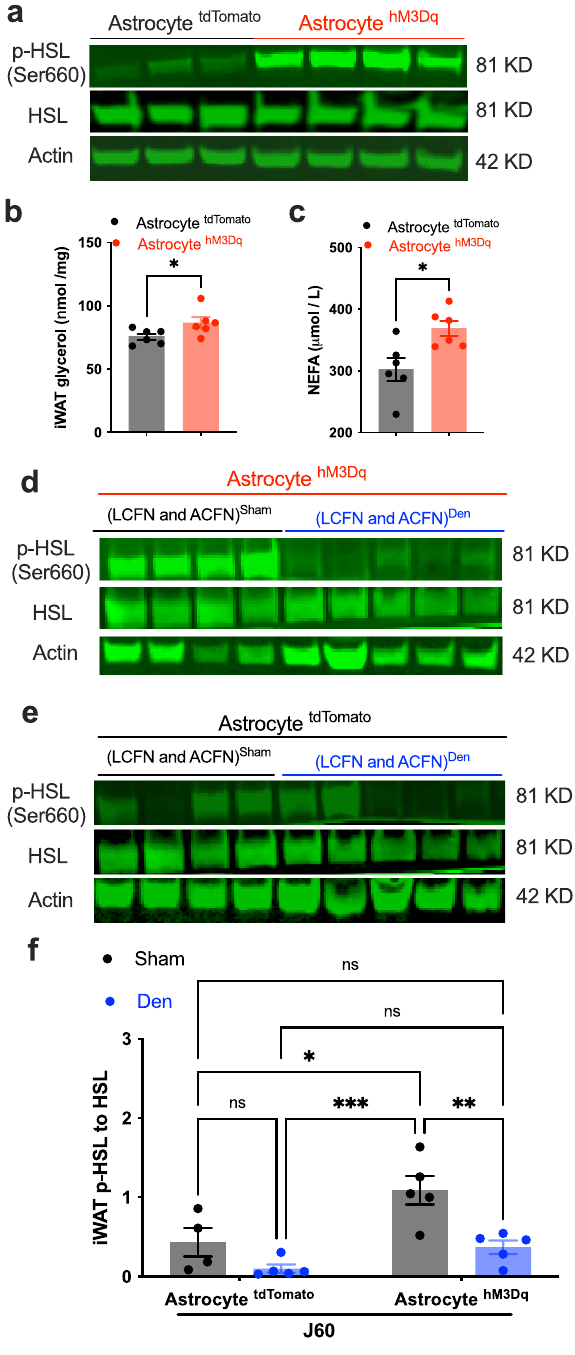
Fig. 6 | Local neural inputs are required for astrocyte regulation of lipolysis. a – c Chemogenetic stimulation of astrocytes in the ARH with J60 via i.p. induced iWAT lipolysis in the astrocyte hM3Dq-transduced mice compared to tdTomato- transduced controls, as evidenced by increased levels of p-HSL and glycerol and plasmaNEFA: a Representativewesternblotsofp-HSLandHSLandactinininguinal iWAT extracted 2h post a single i.p. injection of J60 in astrocyte tdTomato or hM3Dq-transduced mice; b , c Group data of b iWAT glycerol level and c plasma NEFA ( n =6 per group). d – f LCFN and ACFN physical denervation blunted the astrocyte-stimulation-induced HSL phosphorylation: d , e Representative blots of p-HSLandHSLandactinininguinaliWATextracted2hpostasinglei.p.injectionof J60, from astrocyte d hM3Dq- or e tdTomato-transduced mice which received a control Sham or crushing injury to iWAT-supporting LCFN and ACFN; and f Group data of p-HSL over HSL from astrocyte tdTomato or hM3Dq-transduced mice with sham or crushing surgeries respectively (Tdtomato Sham , n =4; Tdtomato Den , n =5; hM3Dq Sham , n =5; hM3Dq Den , n =5). Data represent mean±s.e.m; two-tailed Stu- dent ’ s t -tests for b ( p =0.04) and c ( p =0.01); two-way ANOVA with Sidak post hoc testsfor f (tdTomato ShamtoDen , p =0.48;Sham tdTomatotohM3Dq , p =0.02;tdTomato Sham to hM3Dq Den , p =0.99; tdTomato Den to hM3Dq Sham , p =0.0004; tdTomato Sham to hM3Dq Den , p =0.99; tdTomato Den to hM3Dq Den , p =0.65; hM3Dq ShamtoDen , p =0.008; * p <0.05; ** p <0.01; *** p <0.001; ns, not signi fi